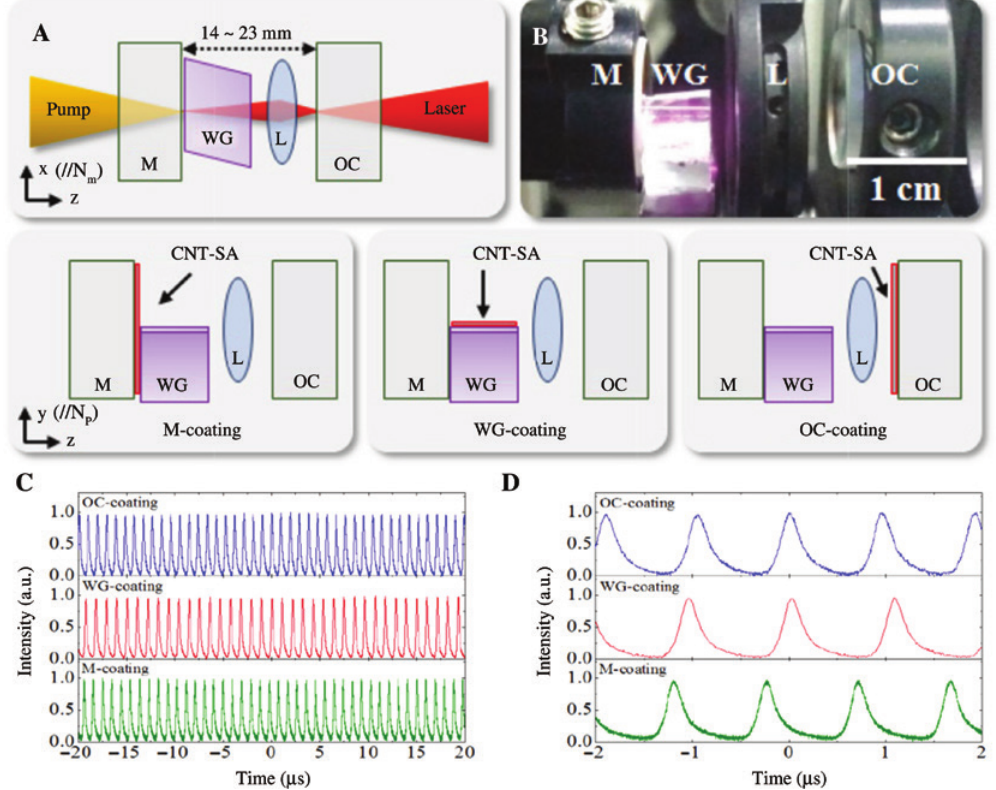
Figure 8: Based on the Yb:KYW planar waveguide laser with CNT SA, a stable pulse train with a pulse duration of sub–300 ns was achieved. (A) Schematic of Yb:KYW waveguide laser with CNT SA for M-, WG- and OC-coatings; (B) The experimental photograph; The Q-switched pulse trains with 3 different coatings in the time span of (C) 40 μ s, and (D) 4 μ s. The shortest pulse durations for 3 different coatings are in the range from 215 to 275 ns. Kim et al. [113] © The Optical Society of America 2019.